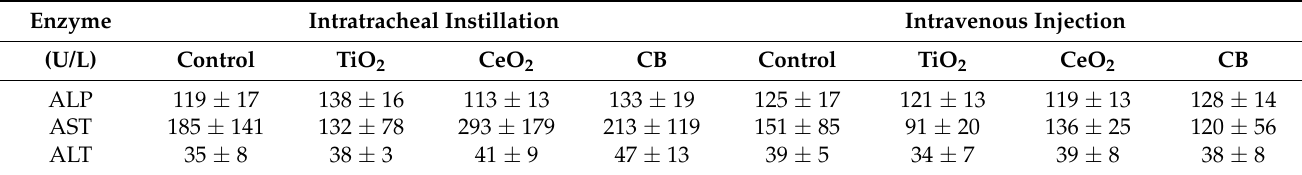
Table 3. Activity of transaminases and alkaline phosphatase (mean ± SD) in plasma of mice 28 days after a single exposure to 162 µ g of TiO 2 , CeO 2 and carbon black nanoparticles administered by intratracheal instillation or intravenous injection. Enzyme Intratracheal Instillation Intravenous